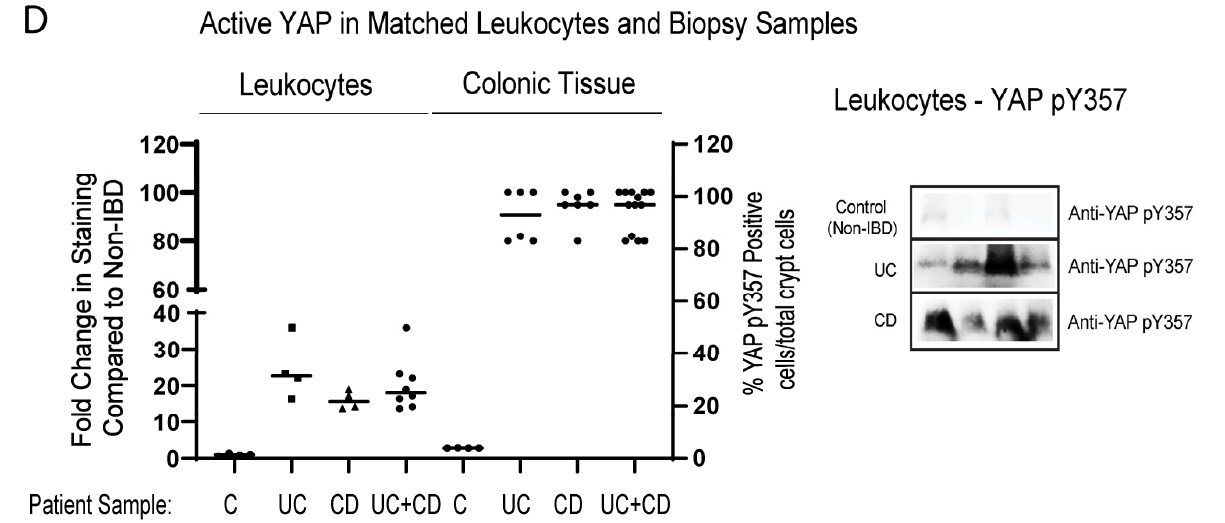
Figure 6. Analysis of biomarkers in matched leukocytes and descending colon sections reveal identi- cal trends, suggesting non-invasive analysis. Leukocyte fraction and descending colon sections were obtained from non-IBD and IBD individuals as indicated. These samples were then immunoblotted for RIPK2 pY474 ( A ), (AMPK α 1) pT172 ( B ), RASSF1A ( C ), and YAP pY357 ( D ). Left panels, summary of fold change in IHC staining of tissue sections and densitometrically scanned immunoblotted results; right panel, representative sections for each patient category. For ( A ) (leukocytes), p value is <0.001 for CD or UC or CD+UC vs. non-IBD samples (n = 5–8 for non-IBD, UC or CD, and 12 for UC+CD). For ( A ) (colonic tissue), p value is <0.0001 for CD or UC or CD+UC vs. non-IBD samples (n = 24 for non-IBD, n = 4 for UC or CD, and 8 for UC+CD). For ( B ) (leukocytes), p value is <0.02 for CD or UC or CD+UC vs. non-IBD samples (n = 6 for non-IBD, UC or CD, and 12 for UC+CD). For ( B ) (colonic tissue), p value is <0.001 for CD or UC or CD+UC vs. non-IBD samples (n = 20 for non-IBD, n = 4–8 for UC or CD, and 12 for UC+CD). For ( C ) (leukocytes), p value is <0.004 for CD or UC or CD+UC vs. non-IBD samples (n = 11 for non-IBD, 15 for UC, 7 for CD, and 22 for UC+CD). For ( C ) (colonic tissue), p value is <0.0001 for CD or UC or CD+UC vs. non-IBD samples (n = 8 for non-IBD, 11 for UC, 7 for CD, and 18 for UC+CD). For ( D ) (leukocytes), p value is <0.004 for CD or UC or CD+UC vs. non-IBD samples (n = 4–5 for non-IBD, UC or CD, and 9 for UC+CD). For ( D ) (colonic tissue), p value is <0.0001 for CD or UC or CD+UC vs. non-IBD samples (n = 4 for non-IBD, n = 6–8 for UC or CD, and 13 for UC+CD).